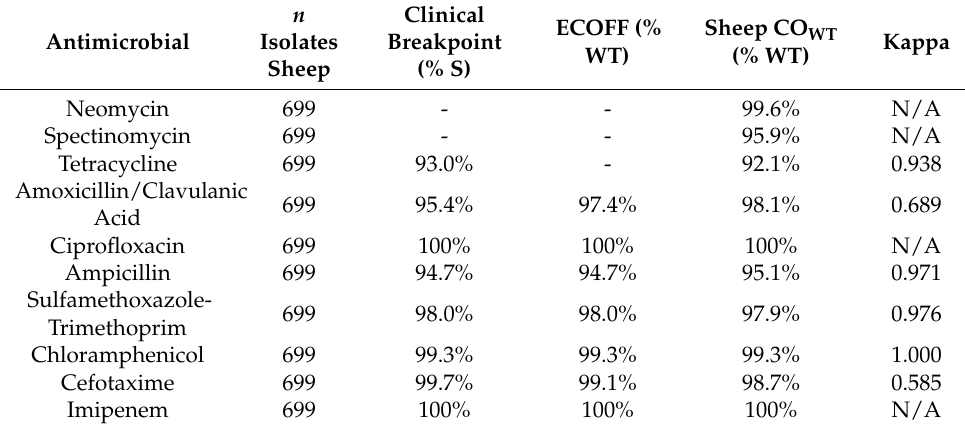
Table 3. Prevalence of antimicrobial susceptible (S) and wild type (WT) E. coli isolated from sheep using clinical breakpoints, ECOFFs and the NRI